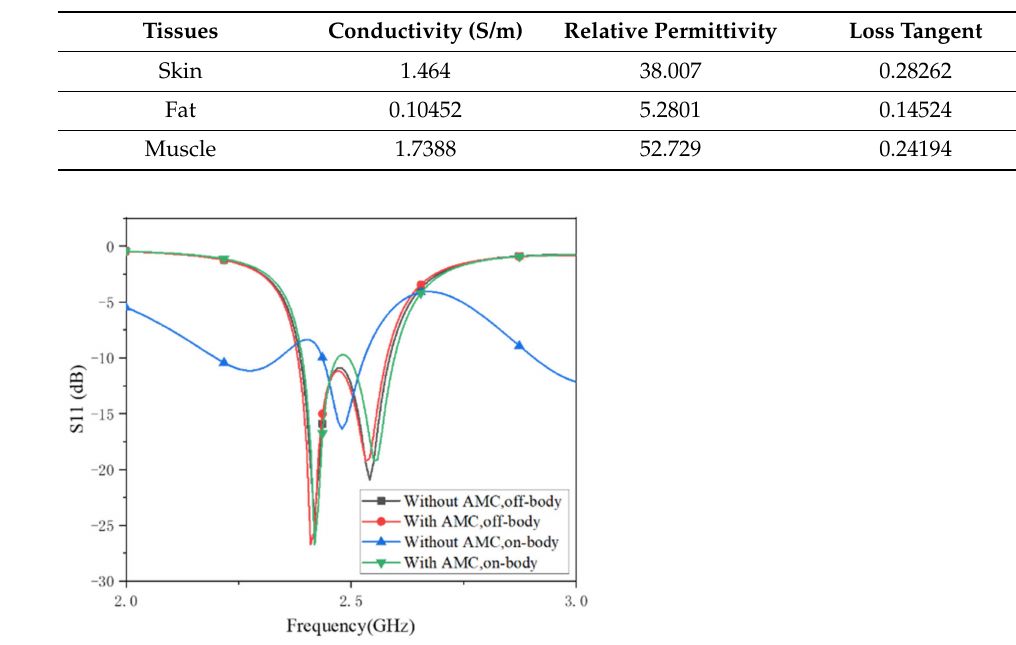
Figure 12. The simulated return loss of the textile slotted microstrip antenna.